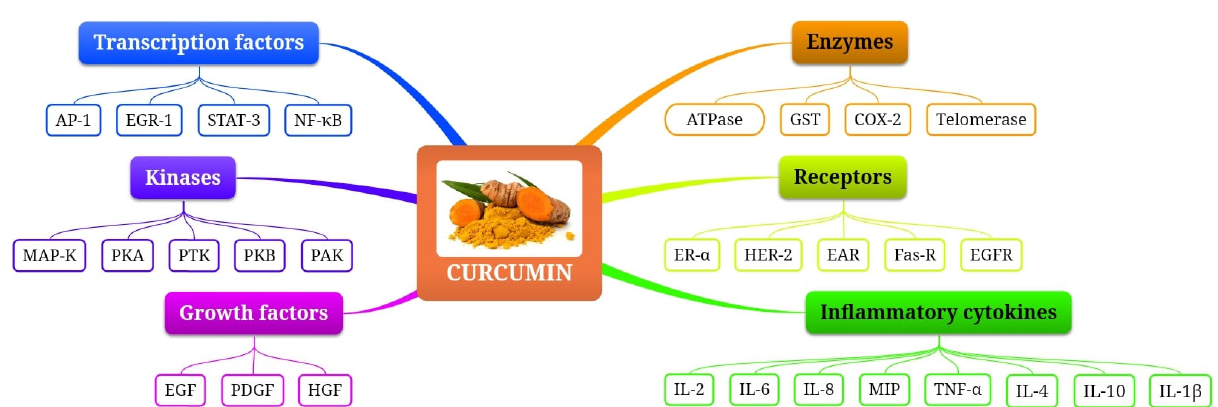
Figure 2. Schematic of curcumin-influenced molecules. Note . AP-1: Activating protein-1; EGR-1: Early growth response-1; STAT-3: Signal transducer and activator of transcription-3; NF- κ B: Nuclear factor- κ B; MAP-K: Mitogen-activated protein kinase; PKA: Protein kinase A; PTK: Protein tyrosine kinase; PKB: Protein kinase B; PAK: p-21 activated kinase; EGF: Epidermal growth factor; PDGF: Platelet-derived growth factor; HGF: Hepatocyte growth factor; GST: Glutathione S-transferase; COX-2: Cyclooxygenase-2; ER- α : Estrogen receptor- α ; HER-2: Human epidermal growth factor receptor-2; EAR, Fas-R: Fas-receptor; EGFR: Epidermal growth factor receptor; IL: Interleukin; MIP: Macrophage inflammatory protein; TNF- α : Tumor necrosis factor- α